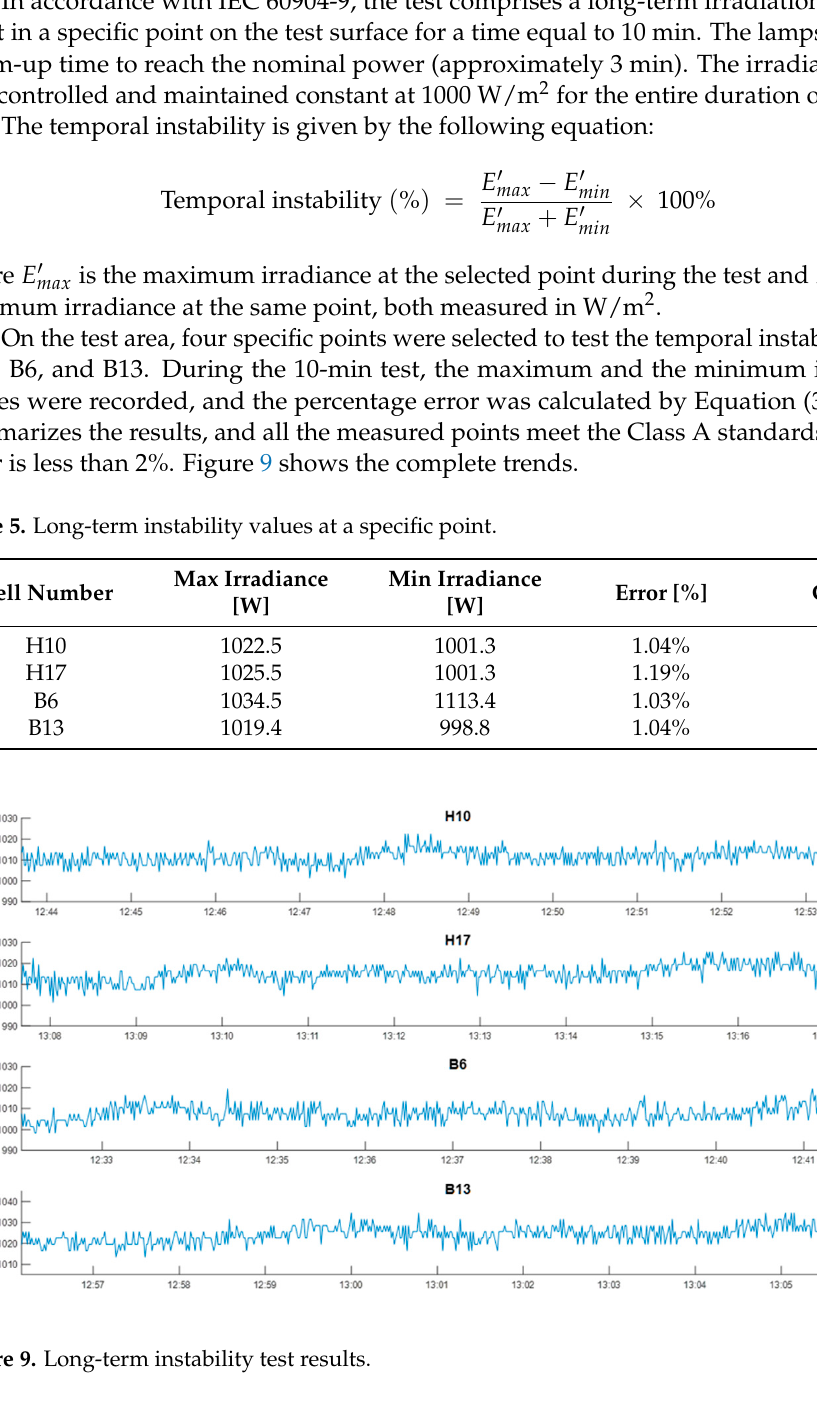
Table 4. Class parameters in testing area.